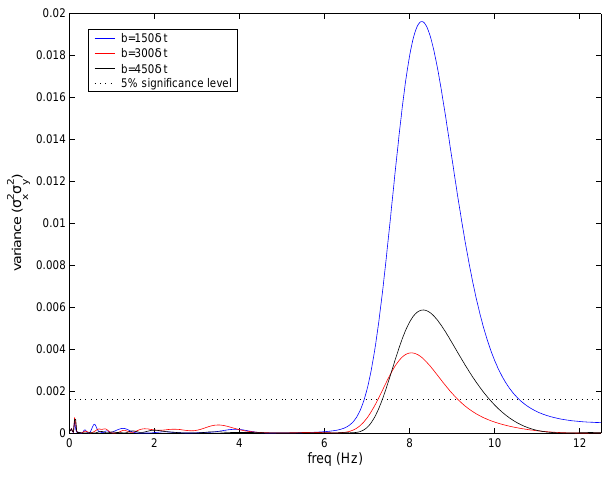
Fig. 1. Squared absolute value of the wavelet cross spectrum Figure 1: Fig. 1 | C xy (a,b) | 2 of two simulated signals given by Eq. (11) and the 5% significance